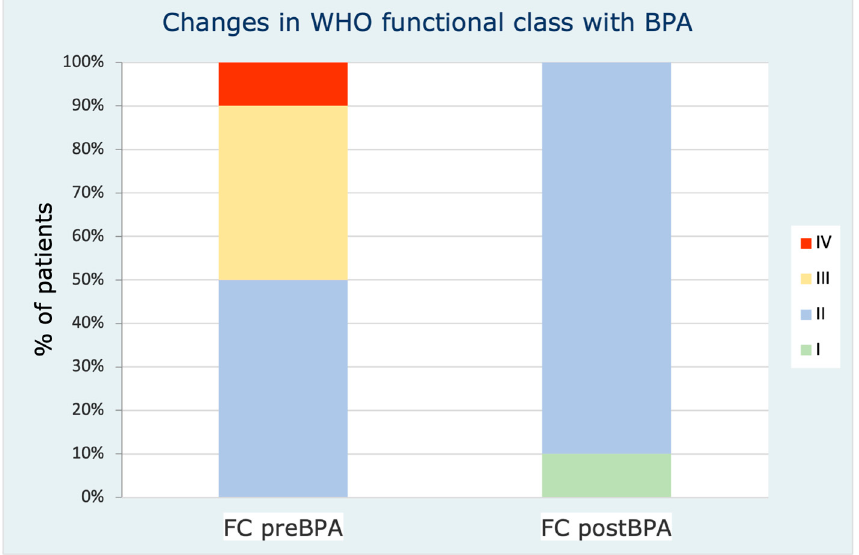
Figure 3. WHO functional class changes after BPA. (BPA: balloon pulmonary angioplasty; FC: functional class; WHO: world health organization).